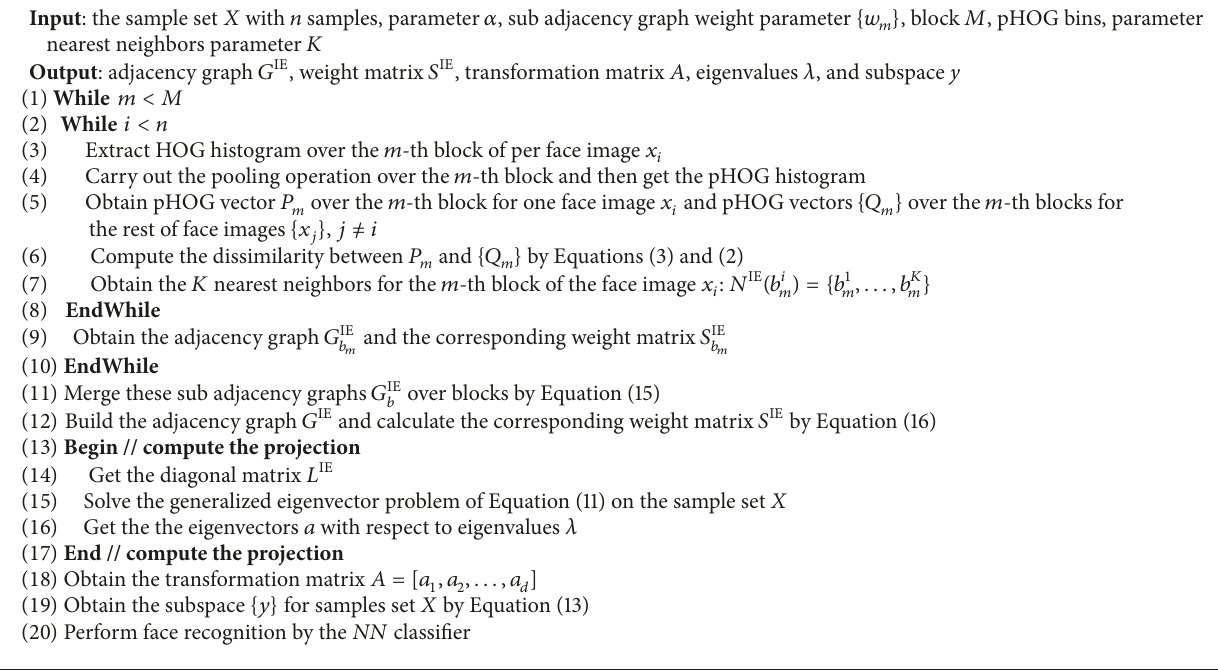
Algorithm 2: The improved EMD metric for block structure